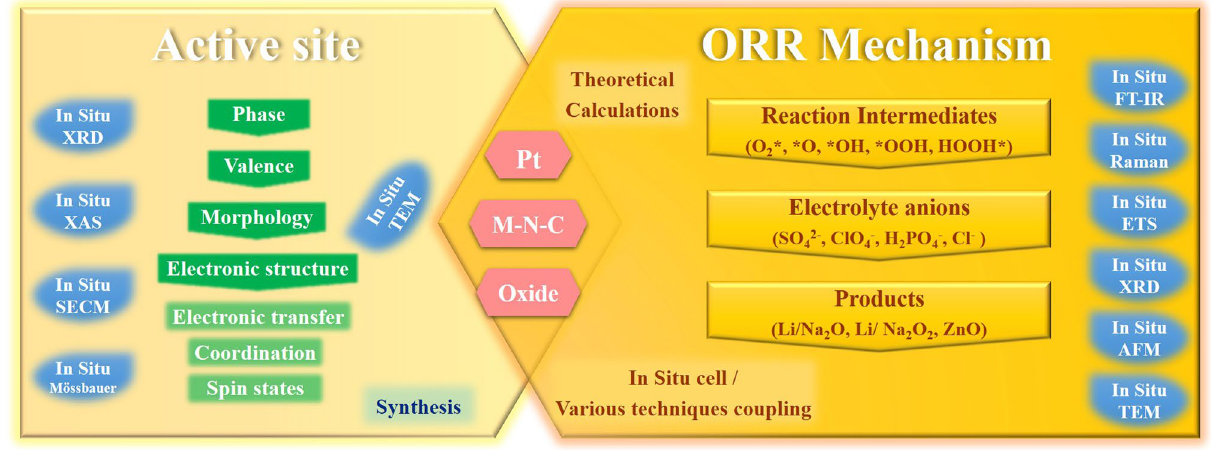
Fig. 1 Schematic diagram of the main overview